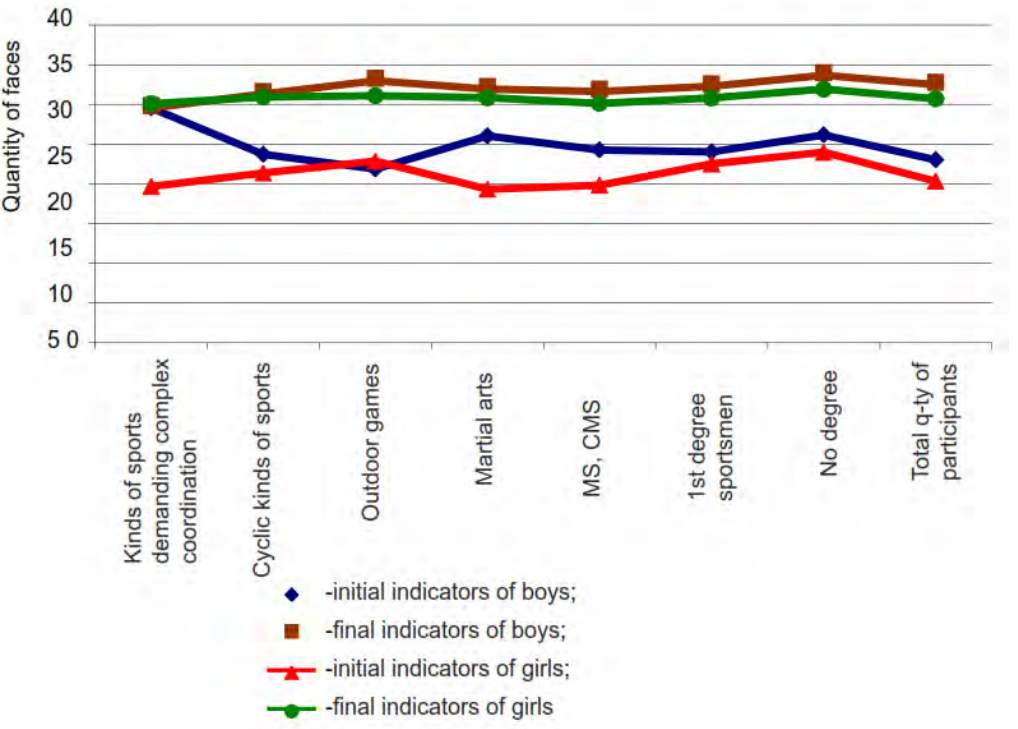
Fig. 15. Indicators, which characterize coordination abilities to maintaining of dynamic balance by first year students of NU